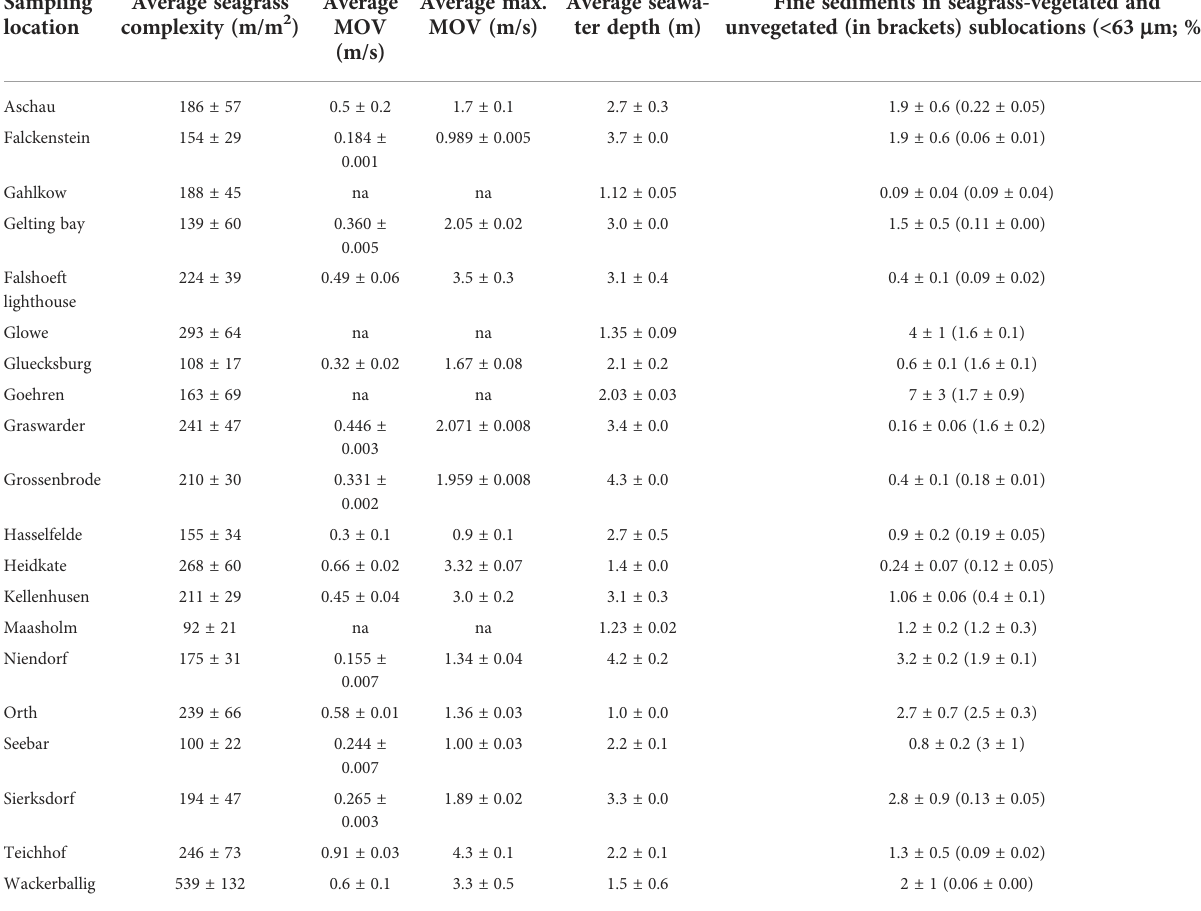
TABLE 3 Summary of average (± SE) of each biophysical variable calculated (seagrass complexity), modeled (average and maximum maximum orbital velocity (MOV)), or measured (seawater depth, % fi ne sediments) in seagrass-vegetated sediments of 20 seagrass meadows along the Baltic Sea coast of